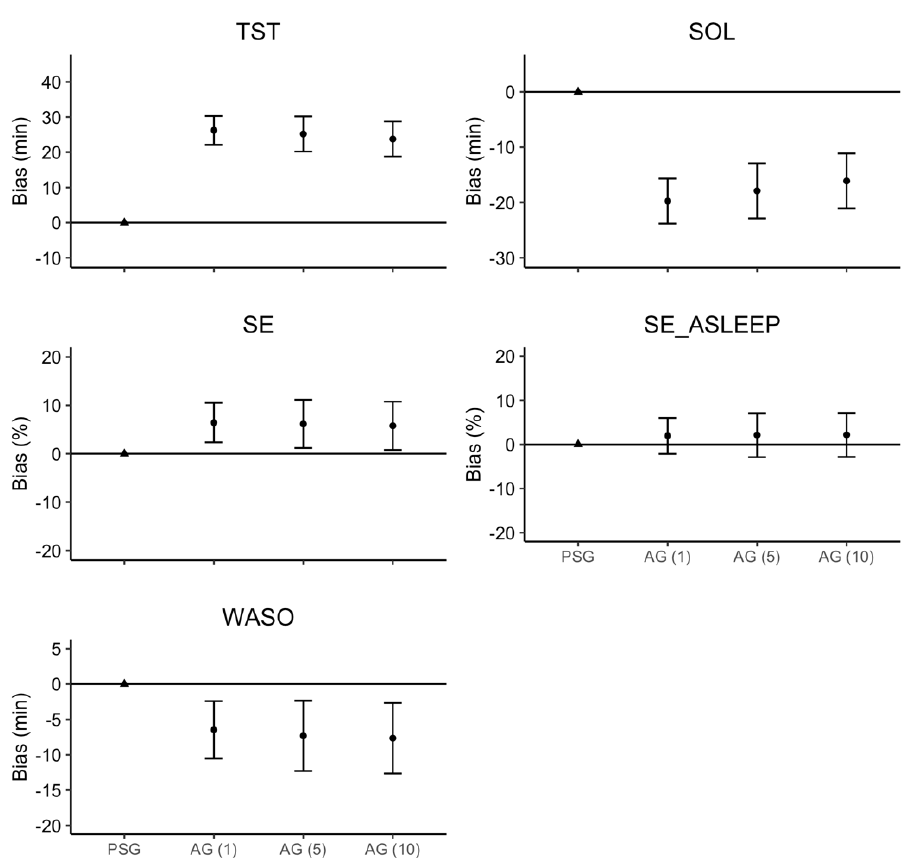
Figure 2. Regression model bias estimates for AG–derived sleep measure . Note: Error bars represent the 95% confidence interval around the bias for each estimate .